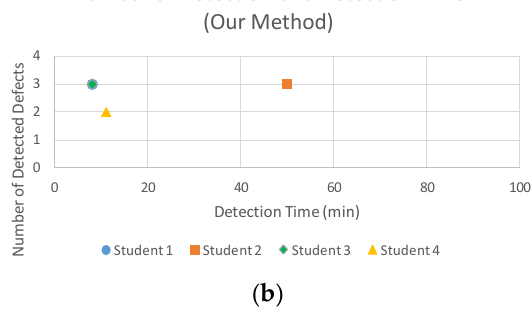
Figure 16. Scatter plots of ( a ) the existing method and ( b ) our method for the number detected defects and detection time.